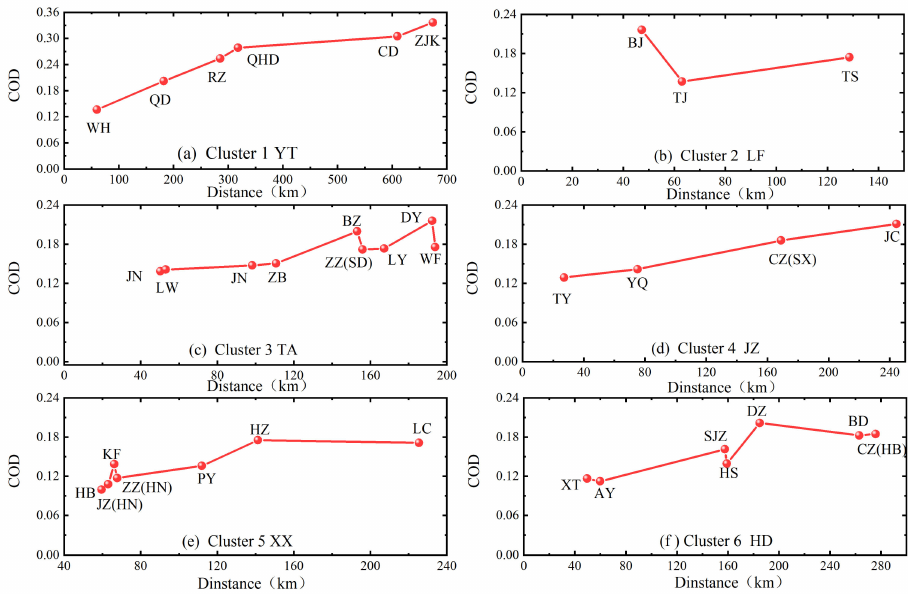
Figure 5. The variations of coefficient of divergence (COD) values with the geographical distance of any other city away from the representative city for the six clustered regions ( a – f ) based on Euclidean distances